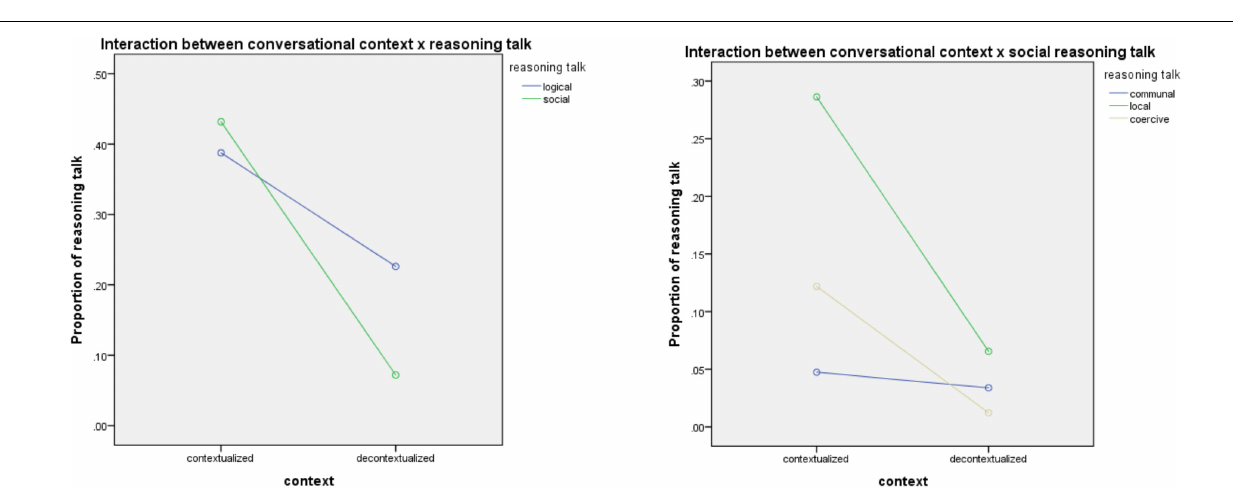
FIGURE 2 | The interaction between communicative contexts × types of reasoning